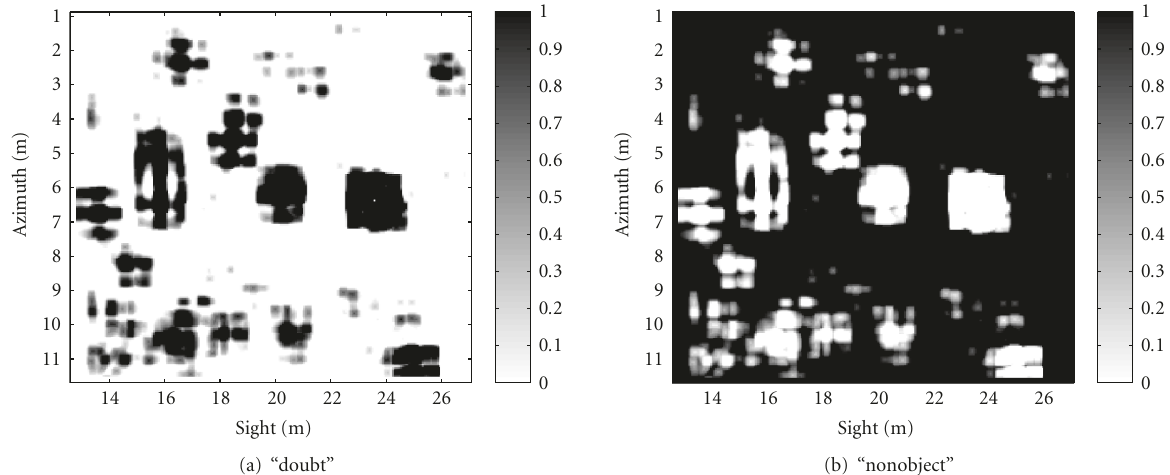
Figure 15: Mass images obtained for each proposition with the kurtosis parameter in image